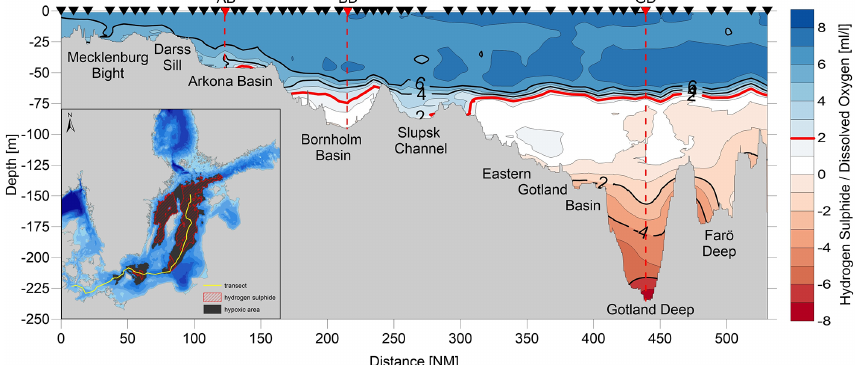
Figure 6. Transect from the Great Belt to Baltic Proper, showing the recent state of dissolved oxygen and hydrogen sulfide (converted to negative oxygen equivalents) concentrations along the pathway of saltwater inflows from the western Baltic Sea to the deep basins (July 2020, IOW cruise EMB242, data source: IOW-DB, https://odin2.io-warnemuende.de/, last access: 28 March 2022). Locations of conductivity– temperature–depth (CTD) measurements and water sampling are marked by black triangles along the track. Red triangles mark the positions of the key stations Arkona Basin (AB), Bornholm Deep (BD), and Gotland Deep (GD) addressed also in Fig. 5. The map (lower left corner) shows the position of the transect (yellow line) and the hypoxic and euxinic area (black and red hatch).